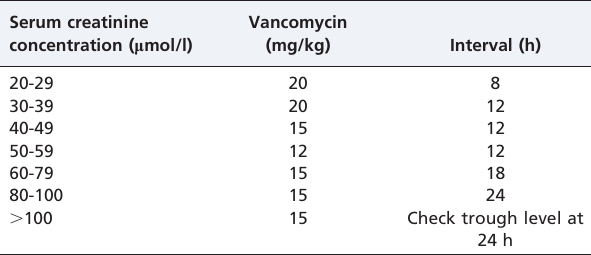
Table 1 - Vancomycin dosage guidelines developed by Grimsley and Thomson (10).